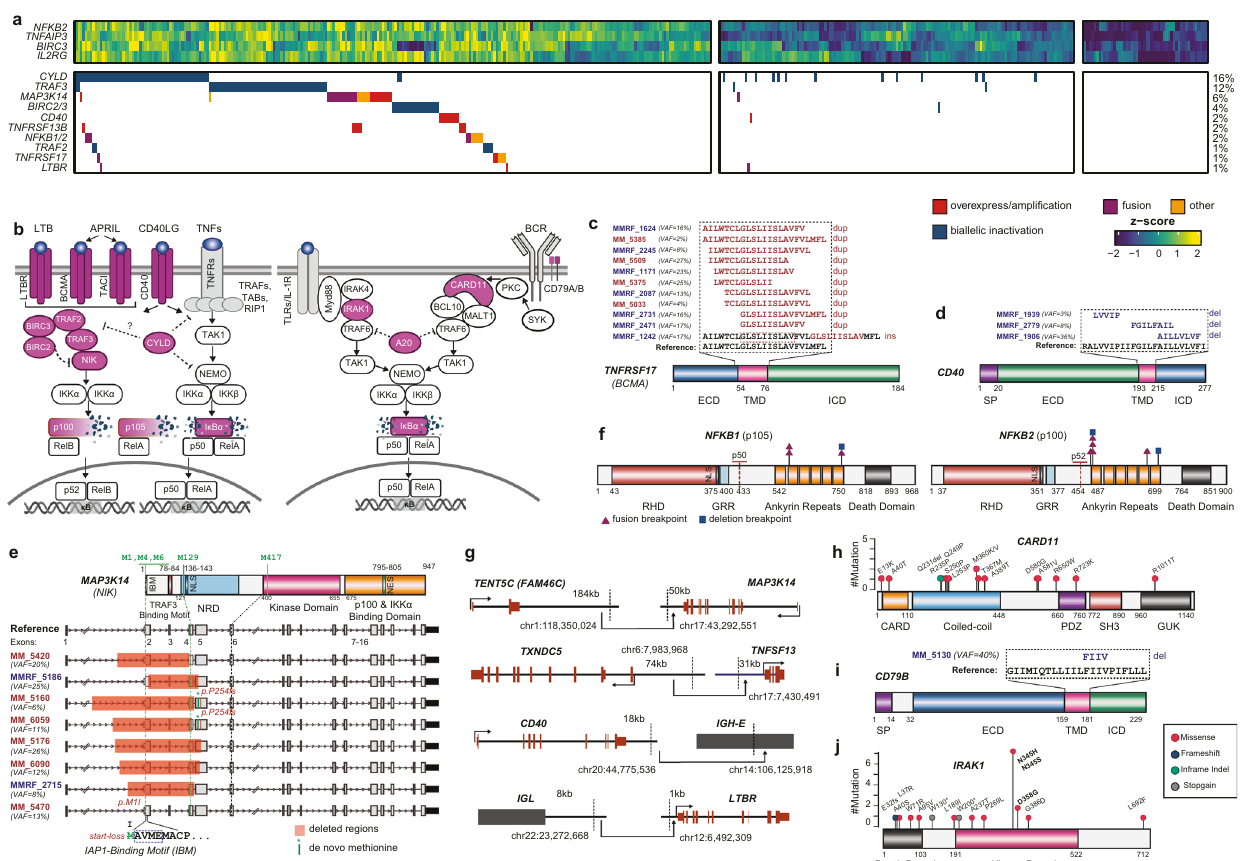
Fig. 2 Diverse alterations of the NF- κ B pathway in relapsed refractory multiple myeloma. a Integrative heatmap for alterations in the NF- κ B pathway for cases with tumor purity greater than 30% ( n = 450). The transcriptomic signature for NF- κ B activation was experimentally derived 16 . “ Biallelic inactivation ” includes homozygous deletion, hemizygous deletion coupled with mutation, or hemizygous deletion or uniparental disomy (UPD) coupled with downregulation of expression (1.5-fold below the cohort median). “ Other ” includes in-frame indels and internal or partial deletions. Frequency of respective alterations is provided to the right. b Summary of the alterations observed in the NF- κ B pathway. Alterations in affected genes (highlighted in violet) were detected in all four branches of the NF- κ B pathway, including TNF receptor family, non-canonical, Toll-like receptor (TLR), and B cell receptor (BCR) signaling. c In-frame tandem duplications or insertions in the transmembrane domain (TMD) of TNFRSF17 . d In-frame deletions in the TMD of CD40 . e N-terminal deletions in MAP3K14 (NIK) truncating the TRAF3 binding site in RRMM. Variant allelic fractions are indicated (VAF). f Schematics of gene fusions and deletions of the C-terminus of NFKB1 (left) and NFKB2 (right). g Translocations that lead to outlier expression of NF- κ B genes, including a kinase ( MAP3K14 ), a cytokine ( TNFSF13 ), and cell surface receptors ( CD40 and LTBR ). Each translocation juxtaposed the gene of interest to a locus with a strong enhancer (IgH, IgL, FAM46C , and TXNDC5 ). Breakpoints are shown as dashed vertical lines. h Lollipop plot for CARD11 mutations in RRMM cohort. i In-frame deletion in the TMD of CD79B . j Lollipop plot for IRAK1 mutations aggregated from RRMM and newly diagnosed MM (NDMM)